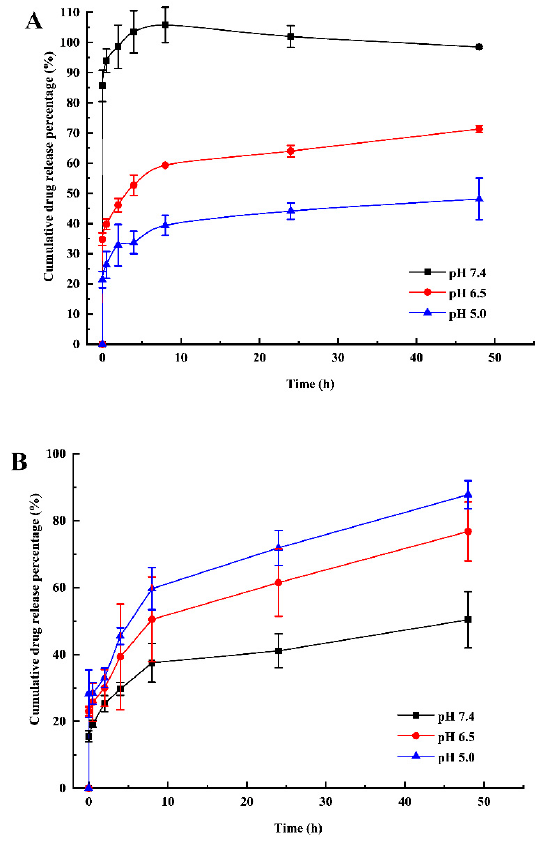
Figure 4. Cumulative drug release under different pH conditions. Percentages of MTX released from ( A ) MTX-mSiO 2 and ( B ) MTX-mSiO 2 @PDA. Data are shown as mean ± SD (n = 3).